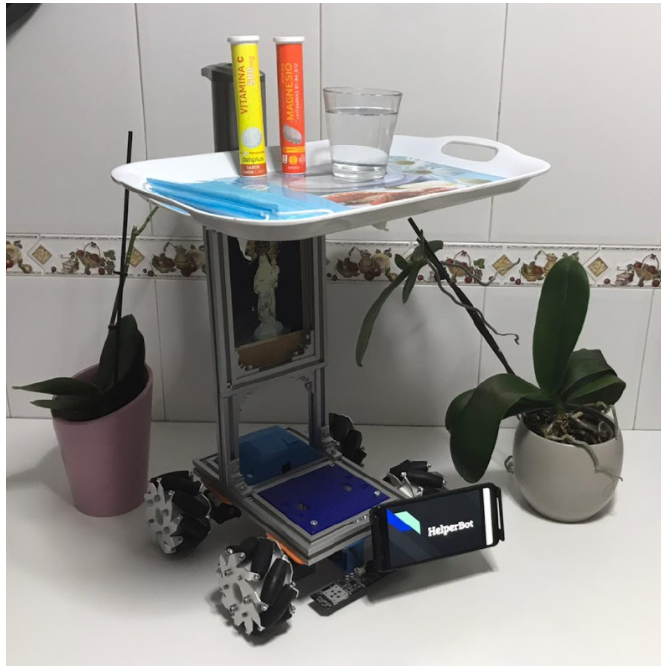
Figure 31. Helper Bot, MiniCernBot’s configuration for medicine